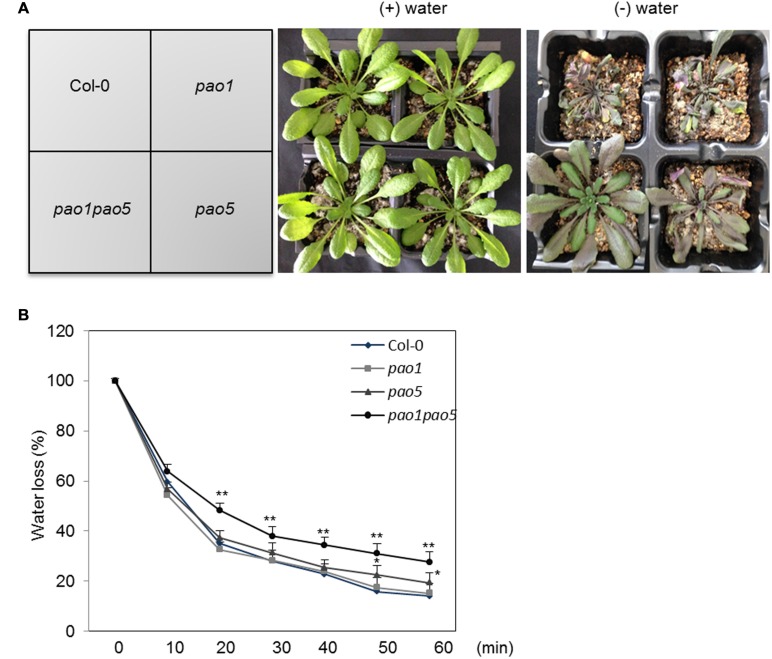
Drought responses of WT, pao1, pao5, and pao1 pao5 plants, and their rates of water loss. (A) Left, WT, pao1, pao5, and pao1 pao5 plants were grown in Vermiculite/Supermix A (1:1 v/v) for 28 days. Right, water supply was stopped at 28 days and the plants were further incubated for 14 days. (B) Water loss rate from WT, pao1, pao5, and pao1 pao5 plantlets. Two-week-old plantlets (n = 25) grown on MS agar medium were carefully detached from the plates and placed onto dry filter paper (Whatman #2) and their fresh weight was measured at various time intervals. Asterisk indicates significant difference: ∗P < 0.05, ∗∗P < 0.01.